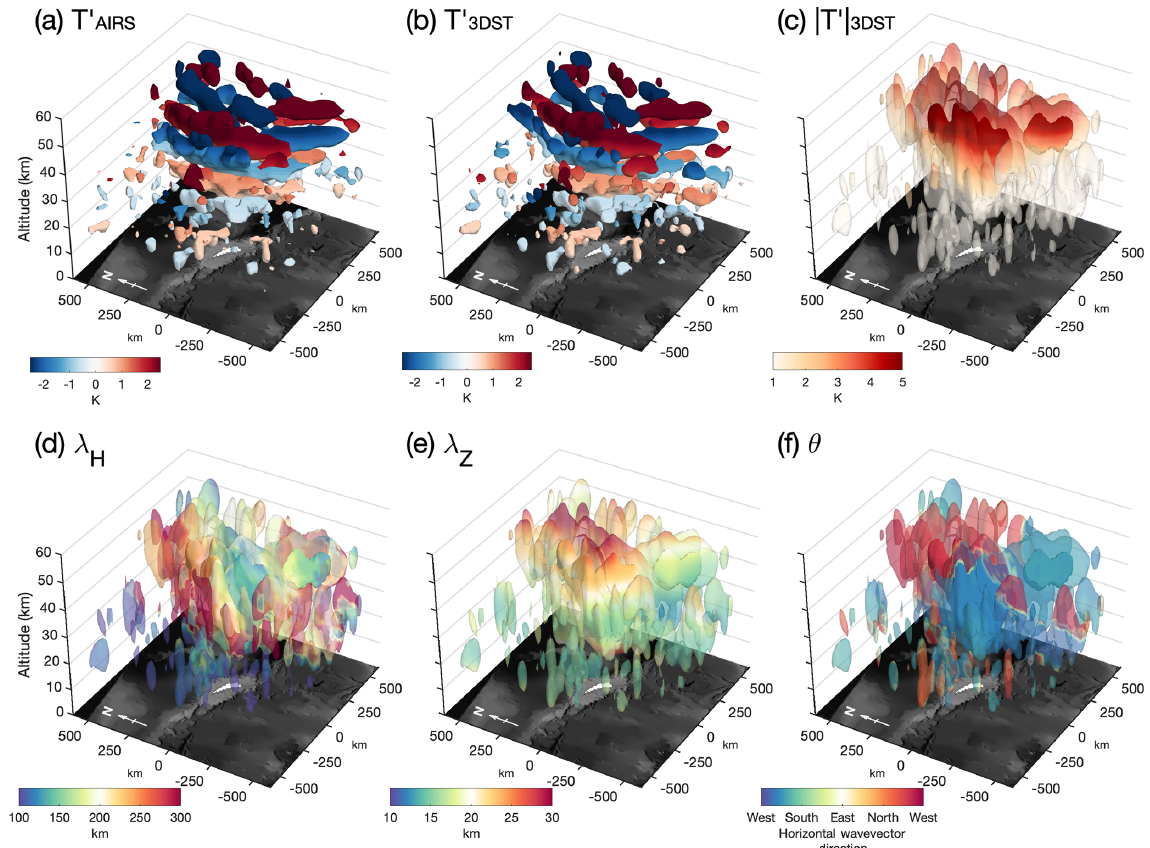
Figure 5. As Fig. 4, but for 3DST analysis of 3-D AIRS temperature measurements over the island of South Georgia (54 ◦ S, 36 ◦ W) on 5 July 2010 (granule numbers 034–035). For details, see text in Sect.